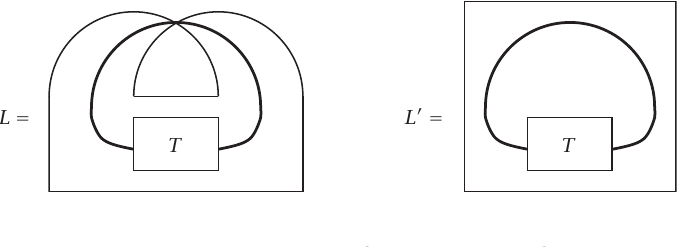
Figure 4.1 . A link in P 2 × I and a link in I 2 × I